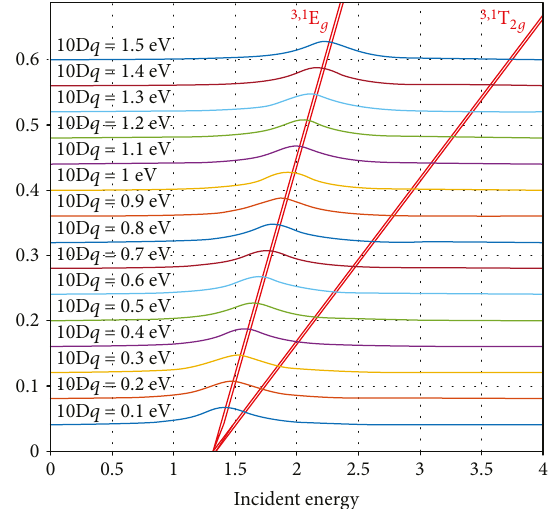
-edge) in dashed red and the corresponding stick spectrum. 2,3 3,1 T 3,1 E 2 g g 10D q = 1.5 eV